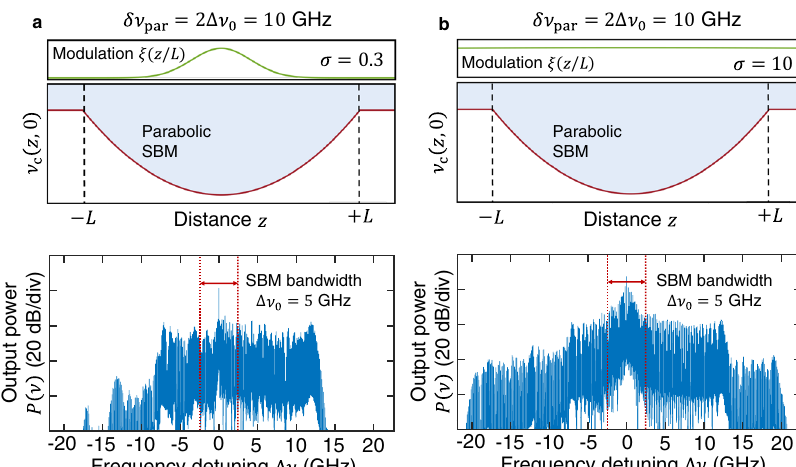
Fig. 6 Optical frequency combs (OFCs) generated by parametric modulations with Gaussian spatial distributions and amplitude exciding the bandwidth of the SNAP bottle microresonator (SBM). a The parabolic SNAP bottle microresonator (SBM) (red line) is parametrically modulated with a (cid:1) (cid:3) ¼ e (cid:4) z = σ L ð Þ 2 (green line) with σ ¼ 0 : 3. The amplitude of the modulation exceeds the bandwidth of the SBM, Gaussian modulation pro fi le ξ z = L δ ν par ¼ 2 4 ν ¼ 10 GHz. The OFC spectrum generated is several times larger than the SBM bandwidth 4 ν ¼ 5 GHz. b A close to uniform modulation 0 0 ( σ ¼ 10) is used to parametrically modulate the parabolic SBM. The bandwidth of the resulting OFC spectrum is several times wider than the SBM bandwidth. Unlike the case of small modulation amplitudes, the frequency comb spectrum generated is comparable to the case σ ¼ 0 :